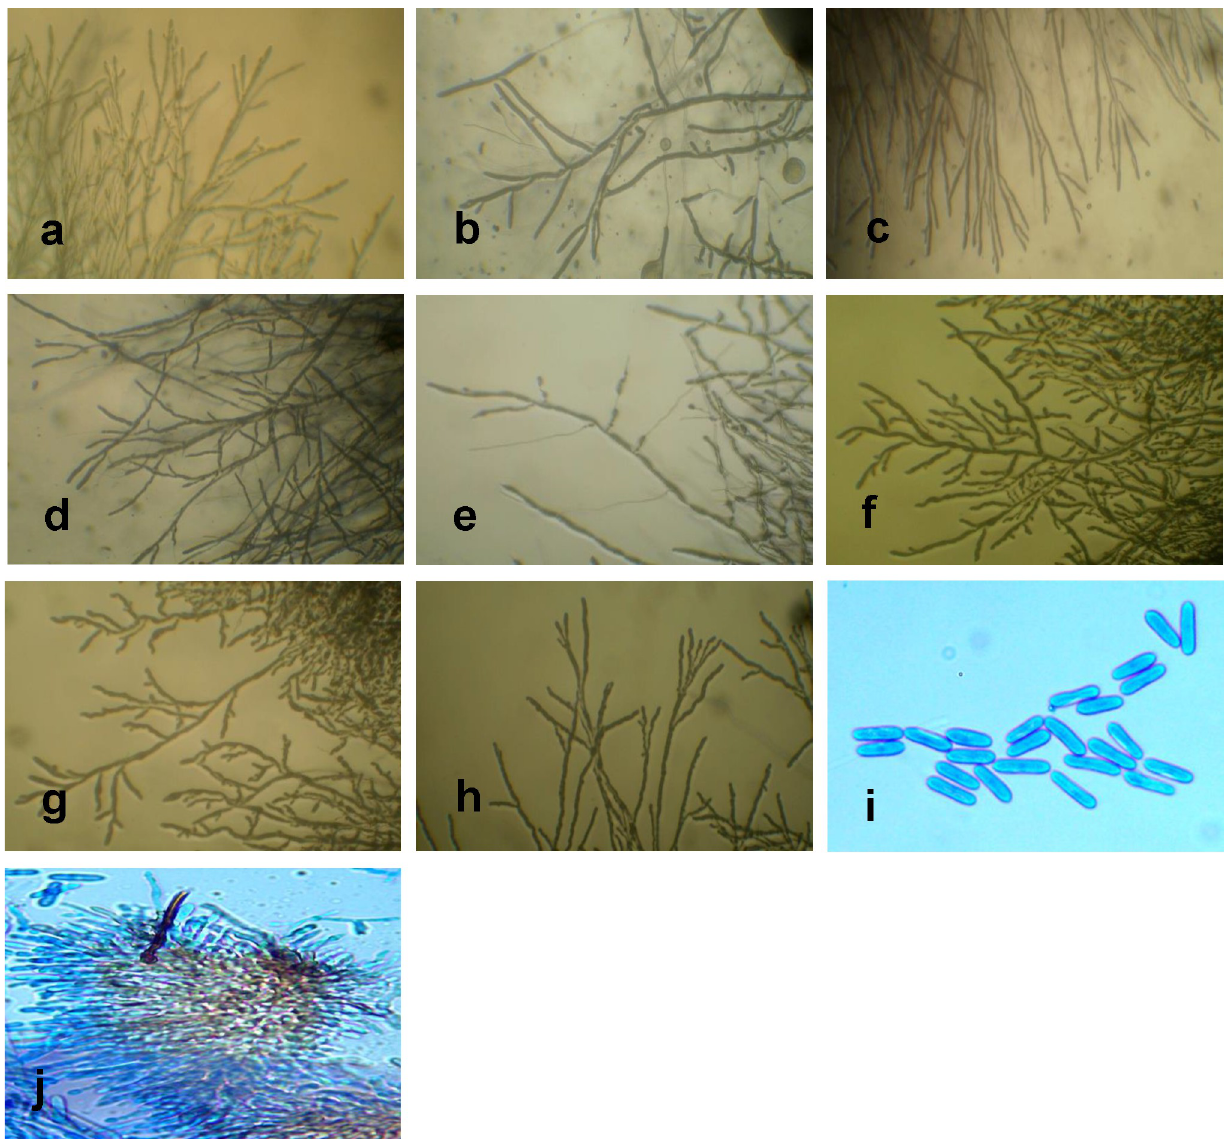
Fig 3. Photomicrographs showing growth pattern of fungi isolates from D . alata (a-e) and D . rotundata (f-h) at 10x.a(Ca5), one sided branching, non- branched tip, distance between branches ranges from 0.5–1.7cm, short bead-like hyphae with swollen tip. b (Lt1), alternate branching, non-branched tip, distance between branches ranges from 0.5–2.0cm, long cylindrical hyphae with tapering tip. c (Ca14), alternate branching, double branched tip, distance between branches ranging from 0.5–2.0cm, long branched thread-like hyphae with slightly swollen tip. d (Ca16), alternate branching with double branched tip, distance between branches ranges from 1.0–2.5cm, long branched thread-like hyphae with swollen tip. e (Ca22), alternate branching with non-branched tip, distance between branches ranging from 0.3–2.5cm, long branched cylindrical hyphae with tapering tip. f (Ca24), alternate branching, double branched at tip, distance between branches of about 0.5cm, short bead-like hyphae with slightly swollen tip. g (Ca32), alternating after two branches, triple branched at tip, distance ranging from 0.5–1.0, short bead-like branch with swollen tip. h (Ca34), alternating after two branches, multiple branched at tip, distance between branches ranging from 0.3–1.8cm, long bead-like hyphae with swollen tip. i, acervuli with dark spines (setae) at the edge of the structure and among the conidiophores. j, oblong and single-celled conidia. ITS regions, including the 5 � 8S and 28S ribosomal RNA genes in all the isolates (Fig 4A). Prim- ers 1 and 3 did not amplify isolate 11 (Lt1), therefore, we used primer 2 for amplification of the ITS1-ITS2 regions, in all the remaining isolates. PCR fragments of approximately 500 bp were